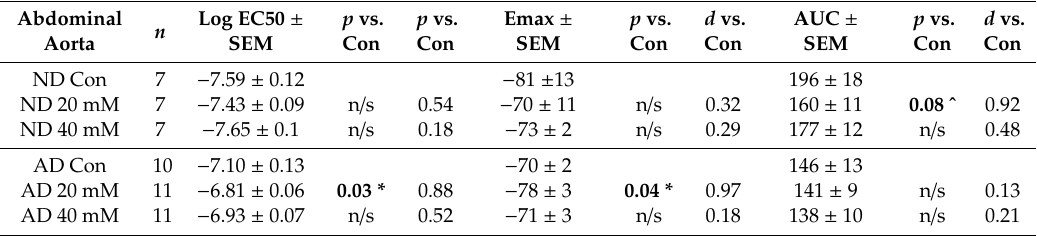
( p ) and e ff ect size (Cohen’s d) in comparison to the control group for each diet. * p < 0.05 vs. control, ˆ p 0.05–0.99 vs.